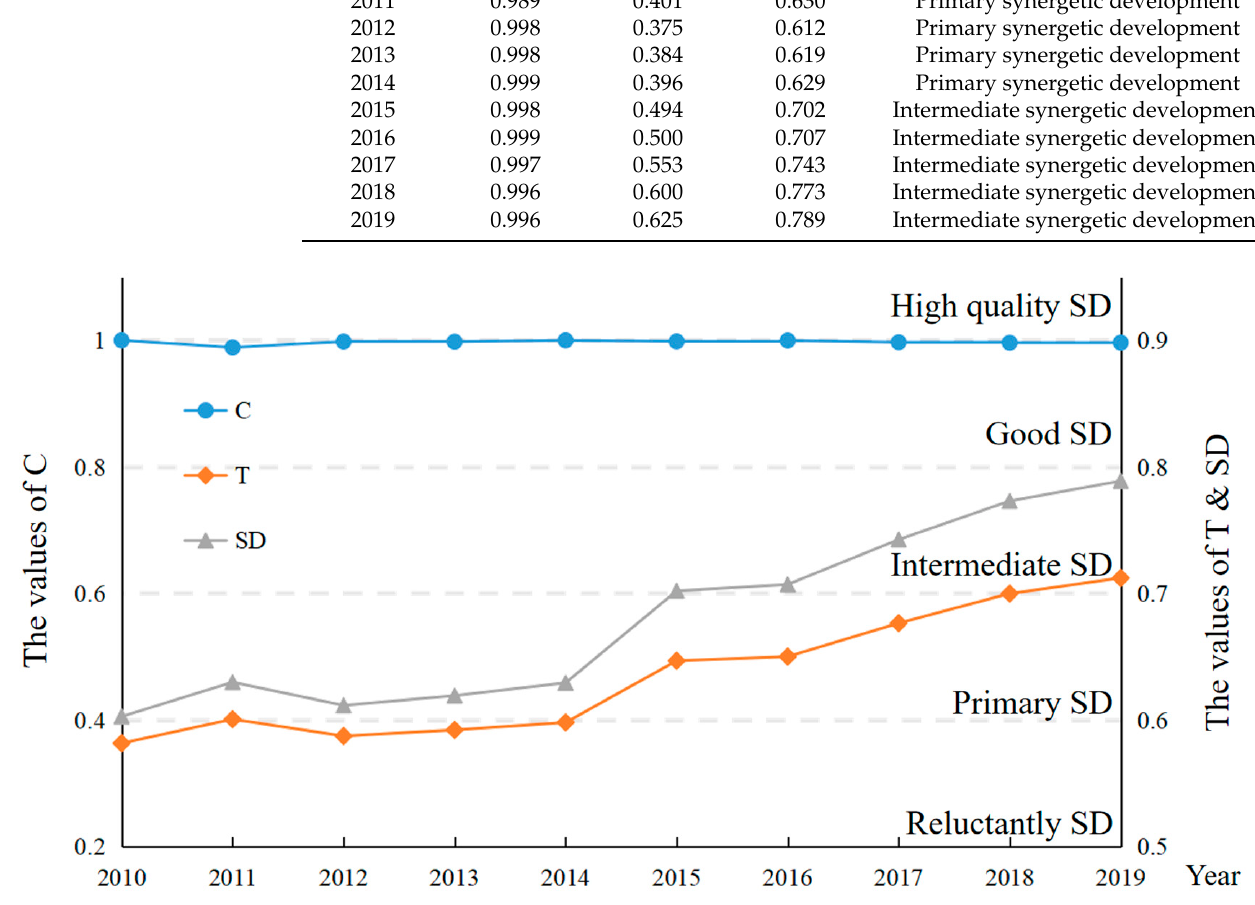
Figure 7. Trends of the C, T and SD and the evaluation classifications of the SD. Table 6. Evaluation results of the SD of water and land resources.